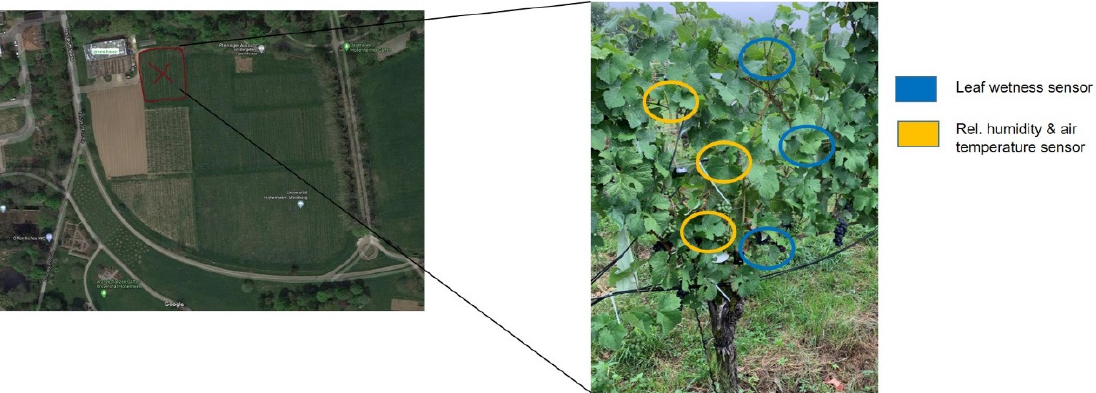
Figure 1. Arial picture of an experimental plot ( left ) and exemplarily the positions of air temperature, relative humidity and leaf wetness sensors at one of the vines ( right ).